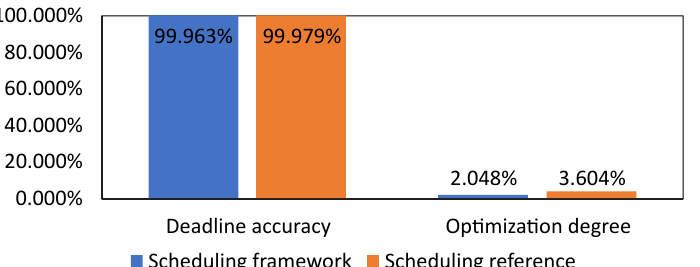
Figure 16. Average deadline accuracy and optimization degree for one